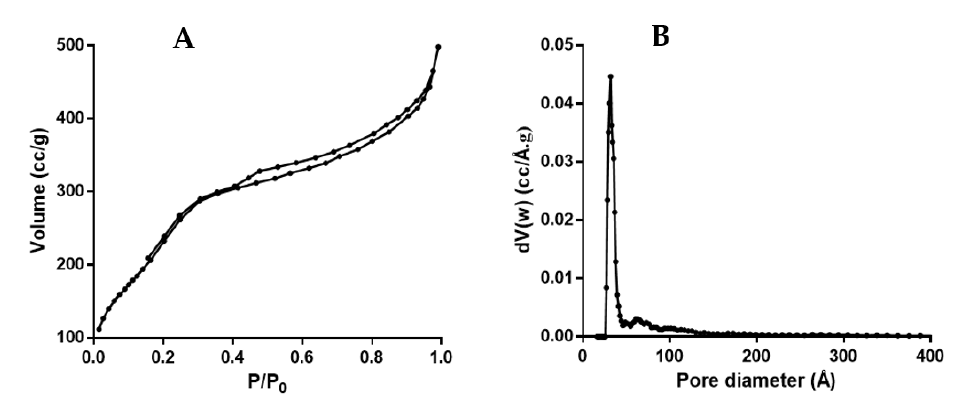
Figure 5. ( A ) Nitrogen adsorption/desorption isotherm at − 196 °C for a representative E-NPs sample; ( B ) pore size distribution for a representative E-NPs sample using an NLDFT adsorption branch model for N2 in silica.